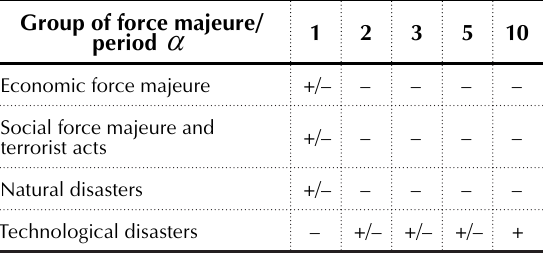
Table 16. Trading simulation results for the PFST